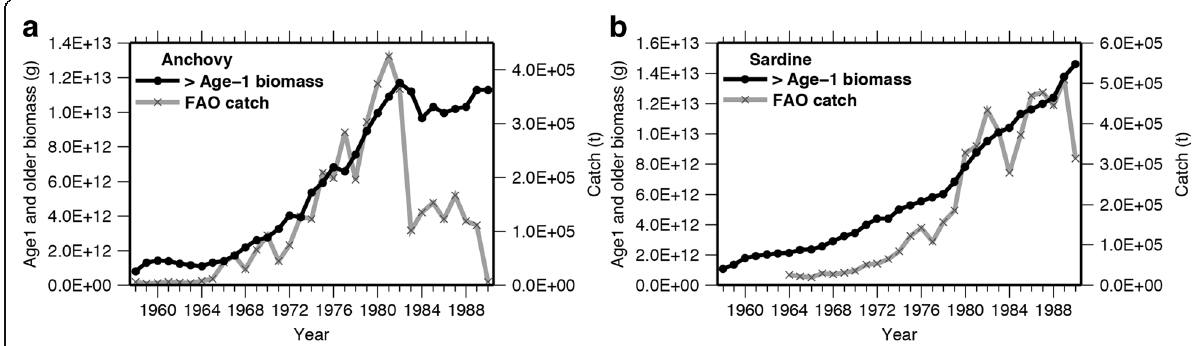
Fig. 1 Comparison between model simulation results and observations for adult population biomass and catch. Model simulated a age-1 and older anchovy biomass and catch from FAO from 1958 to 1990 and b age-1 and older sardine biomass and catch from FAO from 1964 to 1990. Model simulation data is plotted in black line with close circles and FAO data is plotted in gray line with crossed